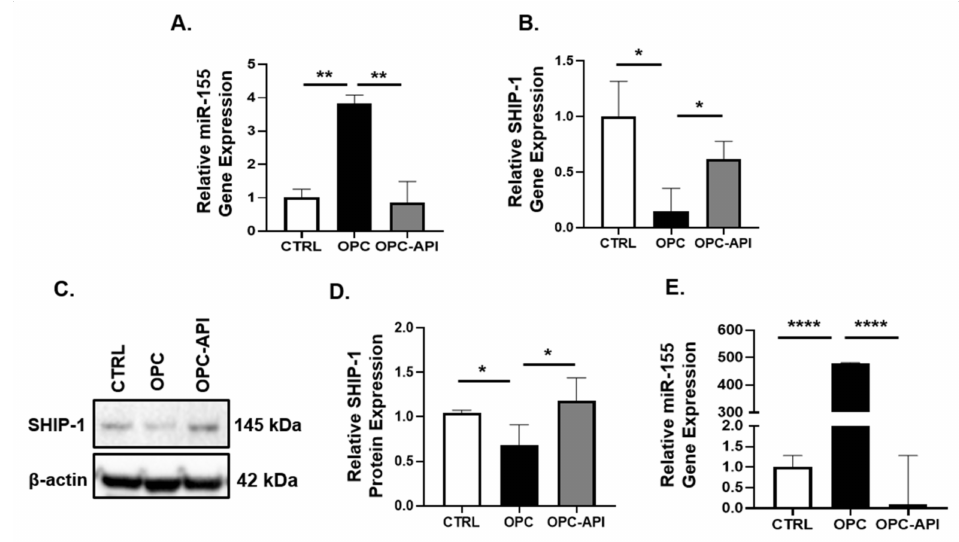
Figure 4. API treatment decreased miR-155 expression in OPC mice, which correlated with increased SHIP-1 expression. Relative ( A ) miR-155 and ( B ) SHIP-1 gene expression in the BM of CTRL, OPC and OPC-API mice. ( C , D ) WB analysis and representative quantification of SHIP-1 protein in the BM of CTRL, OPC and OPC-API mice. ( E ) Relative miR-155 gene expression in the pancreas or tumor of CTRL, OPC and OPC-API mice. Data are presented as the mean ± S.D. of CTRL ( n = 3), OPC ( n = 3–4), OPC-API ( n = 3–4) mice. * p < 0.05; ** p < 0.001; **** p < 0.0001 (by two-tailed t test).